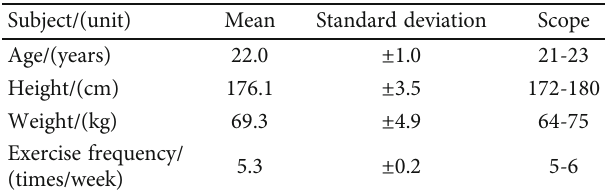
Table 2: Trial 1 subject demographic